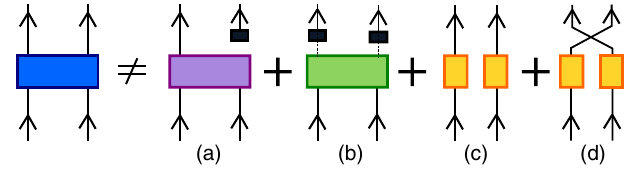
FIG. 7. Example of a nontrivial 2 → 2 connector. The 2 → 2 connector identified in Appendix E cannot be decomposed as a combination of nondeterministic transformations of the following forms: (a) a 2 → 1 connector followed by a preparation, (b) a (global) transformation of the bipartite box into a probability distribution, which we use as a local hidden variable model to build a new box, (c) local mappings on both boxes, and (d) local mappings followed by swapping the two